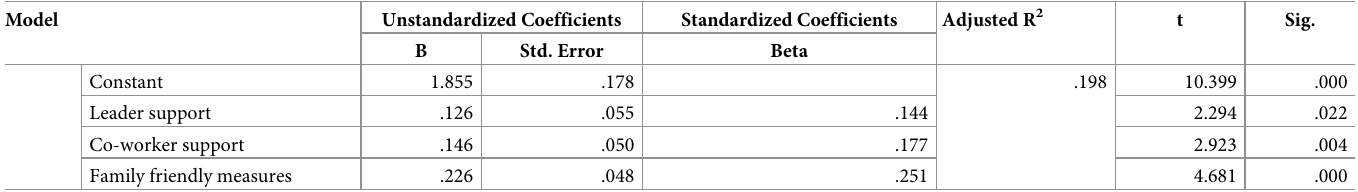
Table 5. Regression coefficients of the impact of the leader and co-workers support in work-family balance and the family-friendly policies and practices, on work engagement.